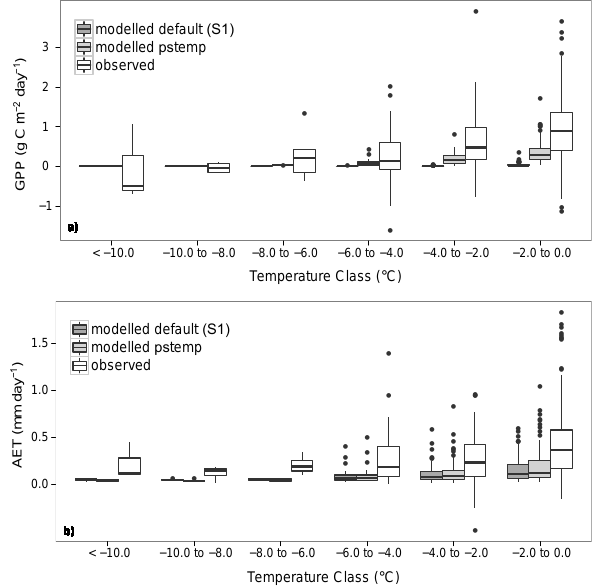
Figure 5. Effect of change in temperature scalar, t scalar , on modelled estimates of (a) GPP (gCm − 2 day − 1 ) and (b) AET (mmday − 1 ). pstemp min for Pinus sylvestris is set to − 10 ◦ C, other values remain unchanged. White: observed values; dark grey: mod- elled default (S1); light grey: changed t scalar function (pstemp). Re- sults for days with net radiation >2MJday − 1 .